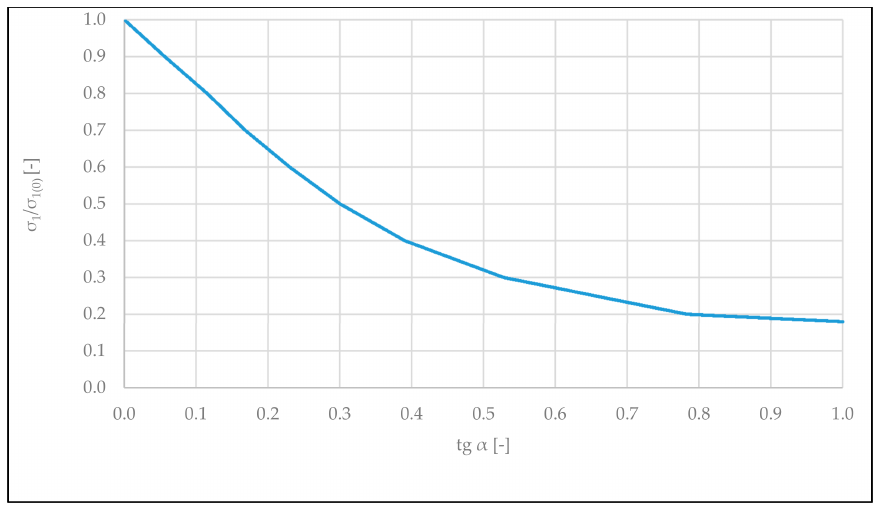
Figure 13. Graph of σ 1 / σ 1 (0) —tg α dependency ( σ 1(0) —the main tensile stresses in the zone of door corner at the coefficient of friction tg α equal to 0).